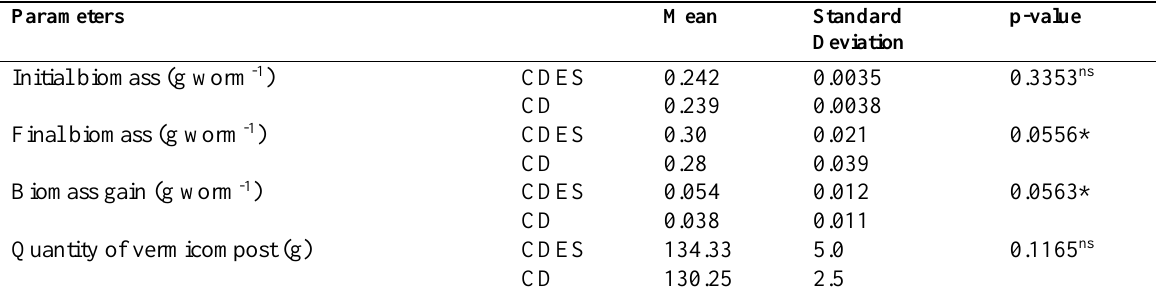
Table 2 Statistical analysis (t Test) of Eisenia foetida growth